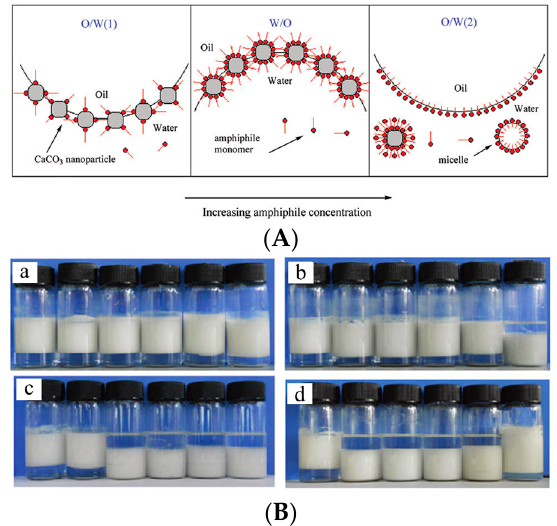
Figure 3. ( A ) Schematic illustration of phase inversion induced by surface adsorption of a series of sodium carboxylates of different chain lengths on CaCO 3 nanoparticles; ( B ) Digital photographs of vessels containing toluene-water emulsions stabilized by CaCO 3 nanoparticles and sodium carboxylate: ( a ) C 6 Na; ( b ) C 8 Nal; ( c ) C 10 Na; and ( d ) C 12 Na at different concentrations, taken 1 week after preparation. Concentration from left to right: (a–c) 1, 3, 6, 10, 30, 60 mM; (d) 1, 3, 10, 30, 100, 300 mM. Adapted with permission from [78]. Copyright 2012, American Chemical Society.